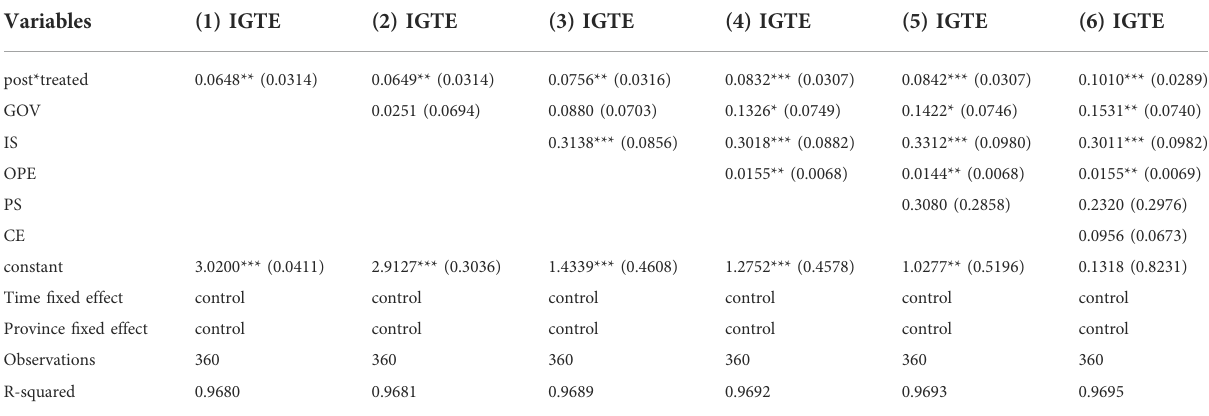
TABLE 2 Baseline regression results of carbon trading policy on